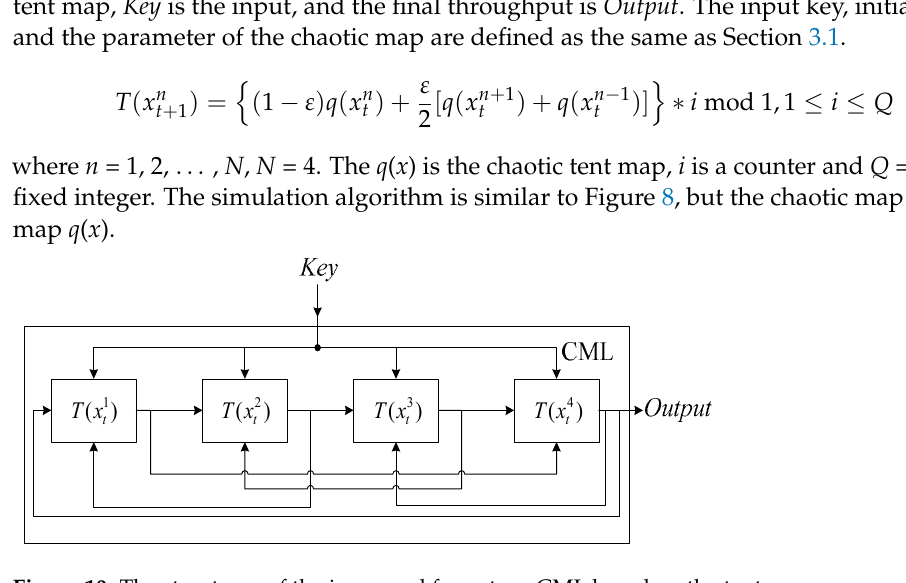
Figure 10. The structures of the improved four stage CML based on the tent map. Figure 11 shows the simulation results of the improved four stage CML based on the tent map, where p ( x t ) is the probability density, t is the time index and x t is the output. In this figure, we find that the result of the improved CMLs with a counter overcome the weakness of the original CML.